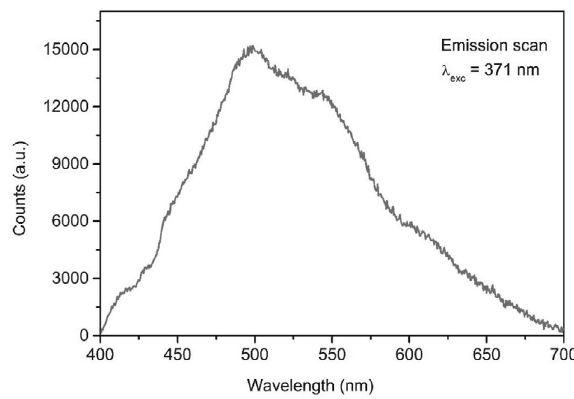
Fig. 8. The emission spectrum of NdVO 4 nanoneedles, measured at room temperature.